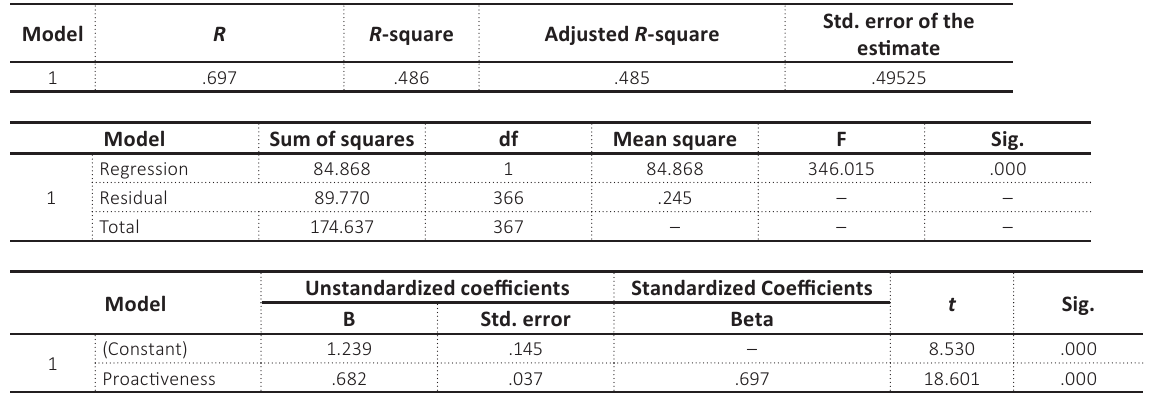
Table 8. Model summary, ANOVA and coefficients of 5th